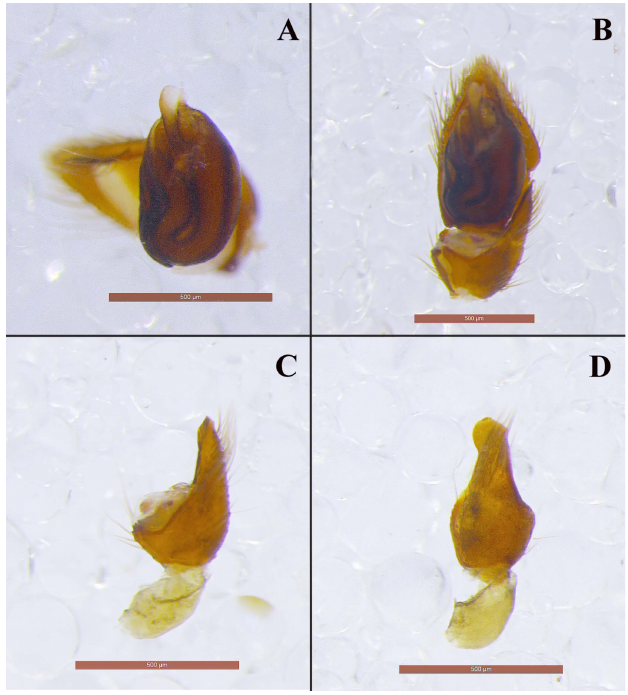
Figure 12. Phaeocedus similaris n.sp. ( A , C , D ) and P.vankeeri ( B ),malepedipalps(holotypes). ( A , B ) Tegulum, ventral view, ( C ) Tibial apophysis, retrolateral to ventral view, ( D ) Tibial apophysis, retrolateral to dorsal view.